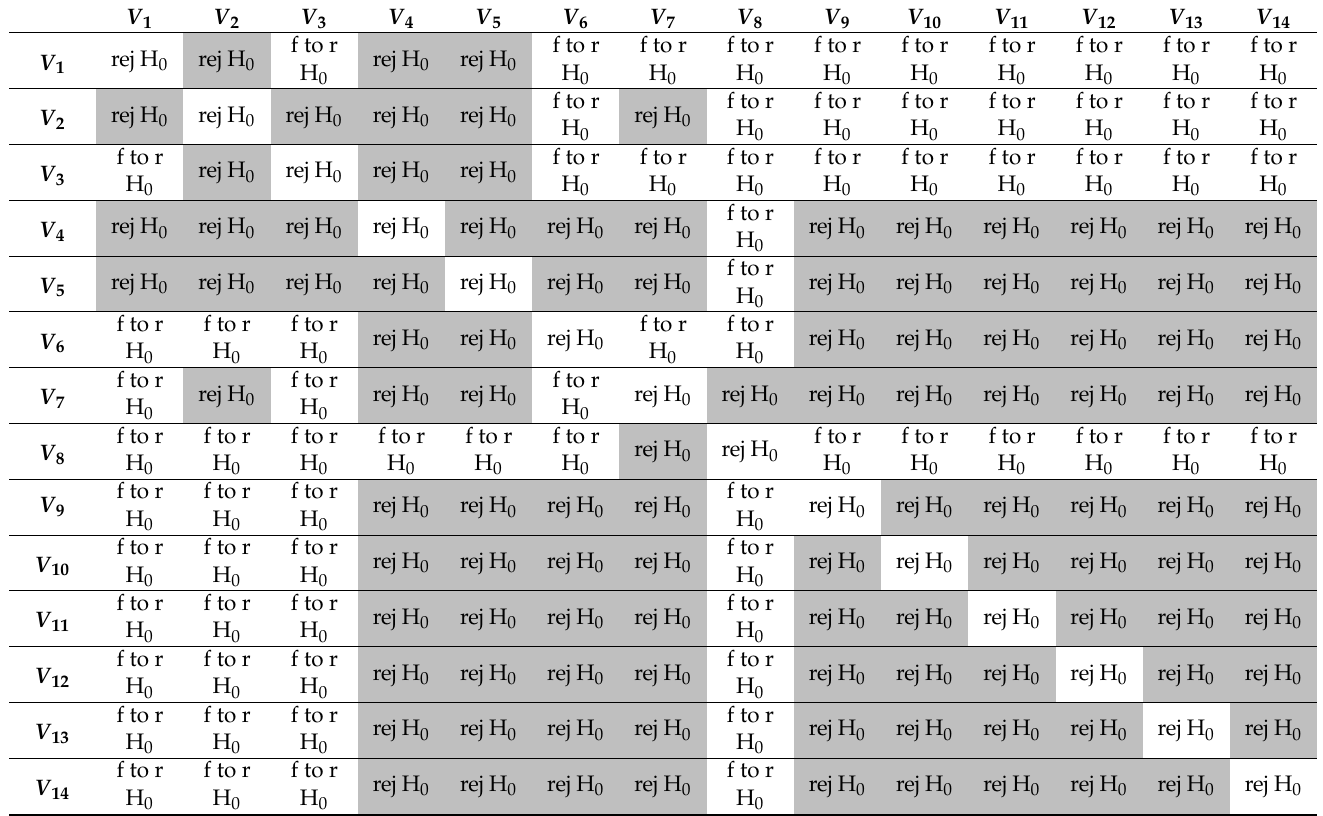
Table 2. Results of the significance test for SRCCs for different pairs of RMS_NVs in the test system V